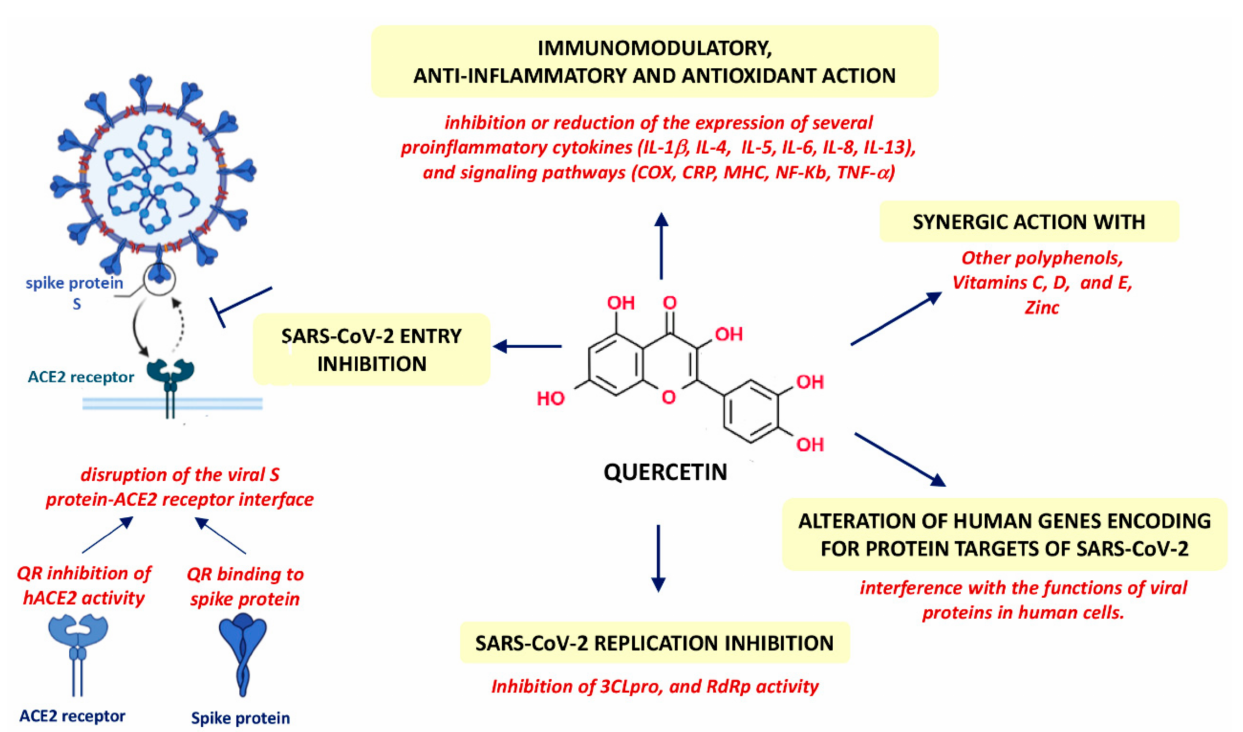
Figure 2. Beneficial multifactorial action of quercetin as a preventive, mitigative, and therapeutic agent of COVID-19